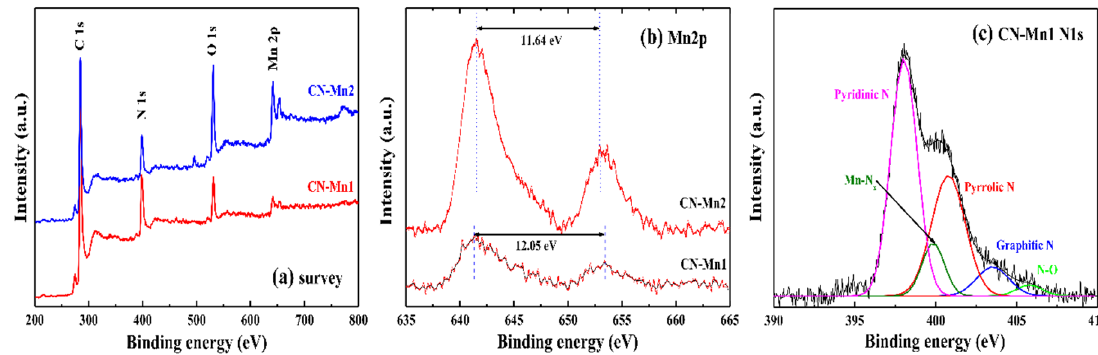
Figure 6. ( a ) XPS survey spectra of CN, CN-Mn1 and CN-Mn2, high resolution spectra of ( b ) Mn2p of CN-Mn1 and CN-Mn2 and ( c ) N 1s of CN‐Mn1.